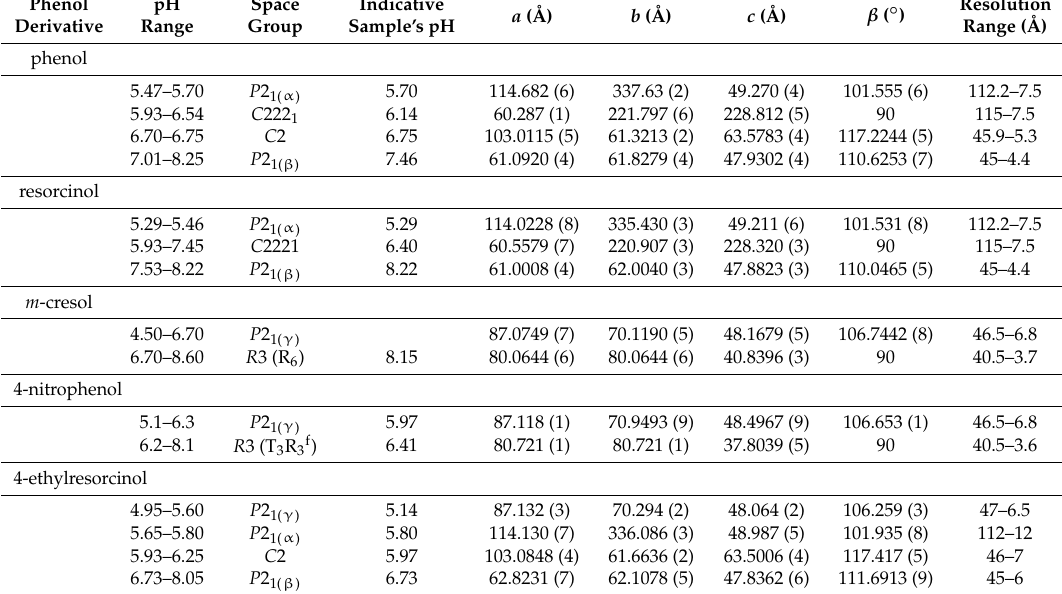
Table 3. Crystallographic properties of human insulin complexes with specific phenol derivatives as extracted from XRPD data (cell values reported, derive from an indicative sample within each pH